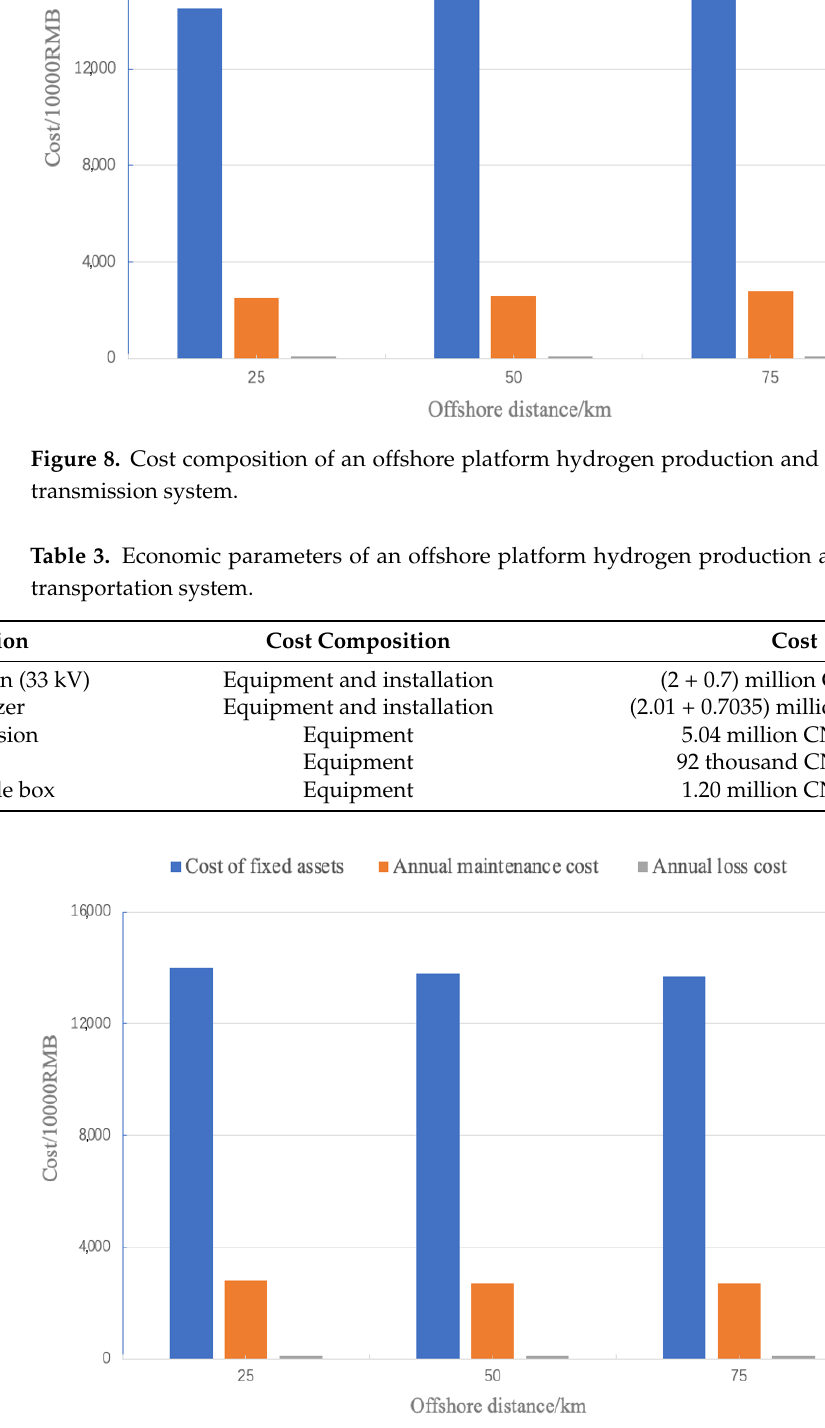
Figure 9. Cost composition of an offshore platform hydrogen production and ship hydrogen trans- portation system.